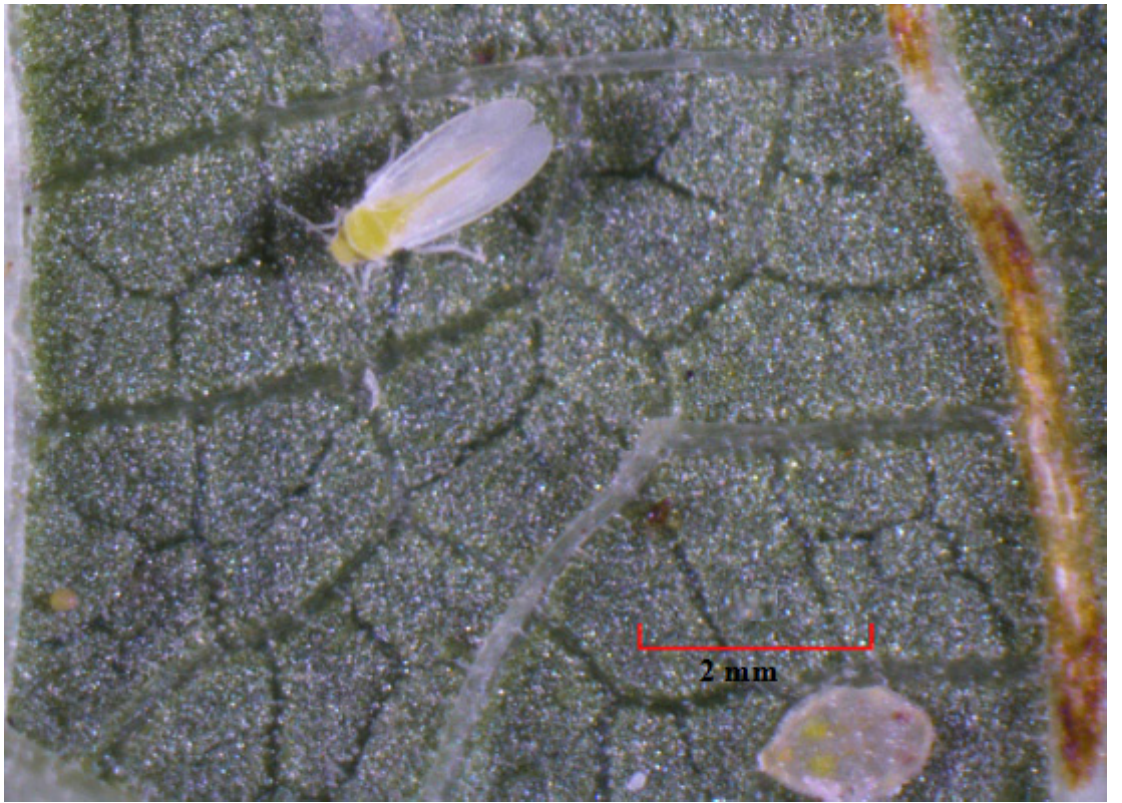
Figure 1. Bemisia tabaci egg (on low left side), adult and fourth instar nymph on the underside of a snap bean ( Phaseolus vulgaris L.) leaf under microscope with 12.6× magnification (Li et al., unpublished).